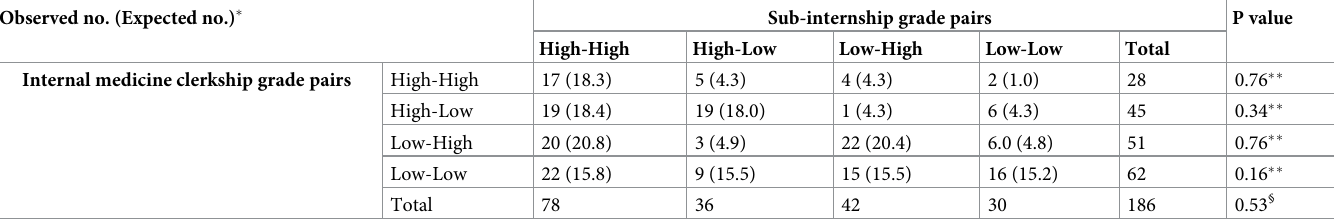
Table 2. Paired student grades for the medicine sub-internship, stratified by third year internal medicine clerkship performance. Observed no. (Expected no.)